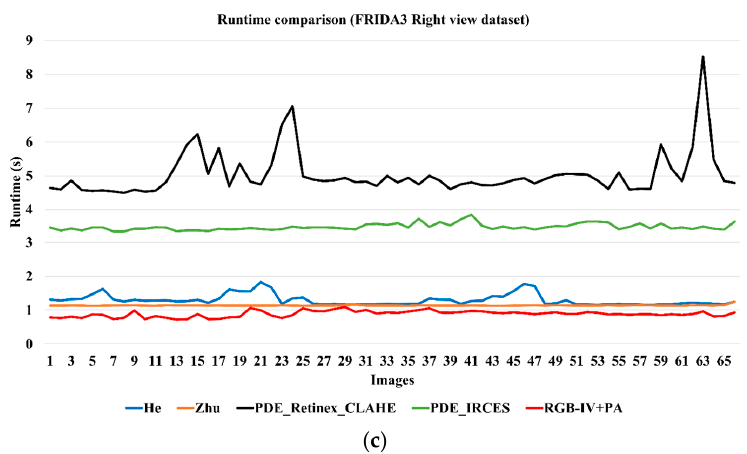
Figure 5. Runtime comparison of various algorithms using ( a ) 53 real and 66 synthetic ( b ) left and ( c ) right view hazy images. ( c ) right view hazy images.